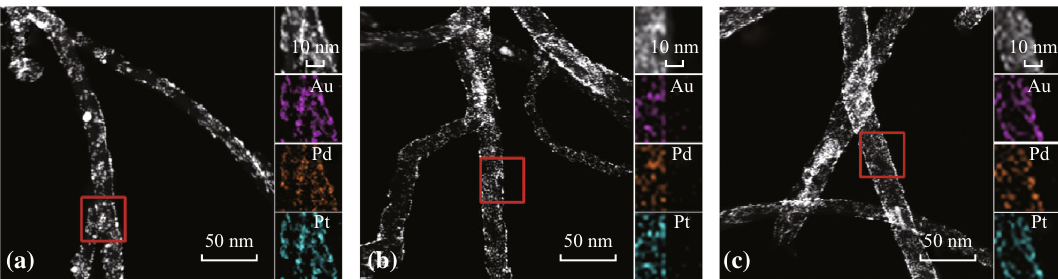
Fig. 2 HAADF-STEM images and regional elemental mapping of the Au, Pd, and Pt content of CNTs-PdAu/Pt trimetallic NPs with different Pd/Au/Pt ratios: a 1:3:2, b 2:2:2, and c 3:1:2